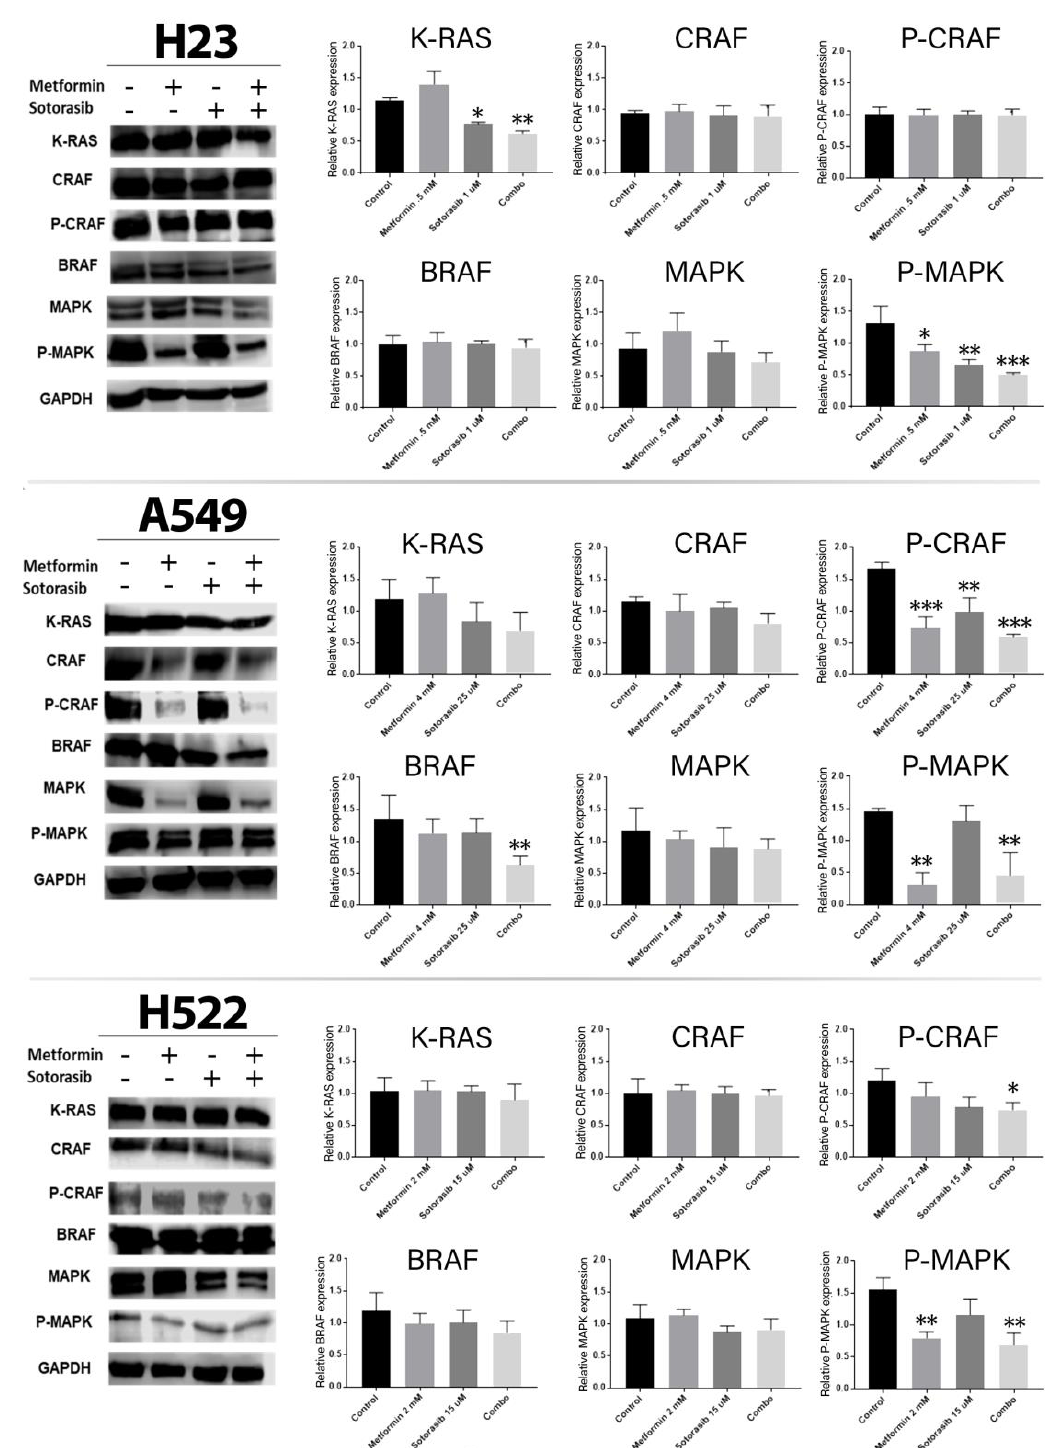
Figure 3. Effect of the combined treatment of metformin and sotorasib on the MAPK pathway. Cells were seeded and treated for 72 h with their respective therapy, after which protein was extracted and analyzed by Western blot. GAPDH was used as endogenous control, and Western blot images were analyzed by ImageJ software version 1.54 (NIH) and represented as bars in the graphics using GraphPad Prism software version 8.0.1 (Dotmatics, Boston, Massachusetts, USA). Each bar represents three independent experiments and results of the area are presented as mean and standard deviation. Data were normalized regarding endogenous control and statistically analyzed by one-way ANOVA. * p ≤ 0.05, ** p ≤ 0.01, *** p ≤ 0.001. MAPK and p-MAPK both refer to ERK1/2 and p-ERK1/2.